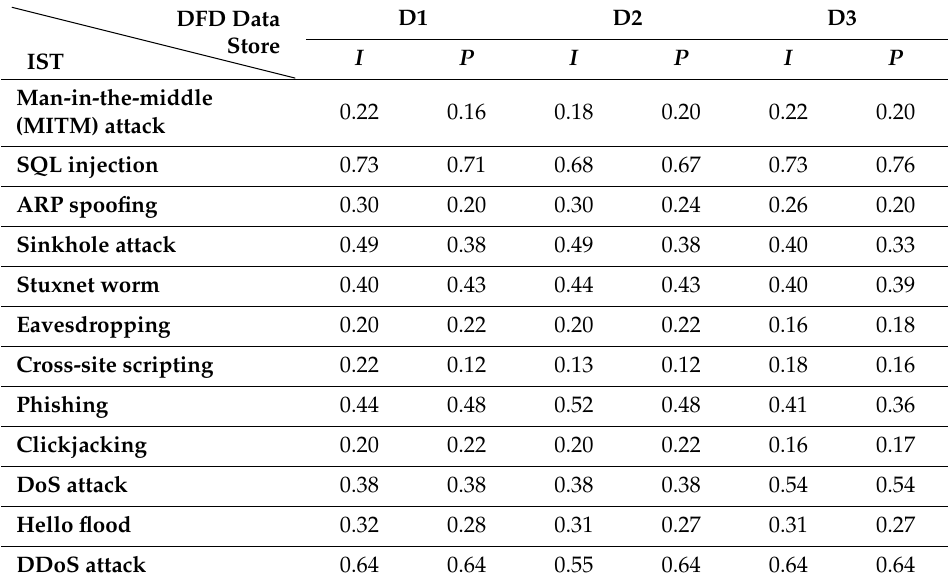
Table 4. The IST evaluation scores for DFD Data Store of the ELB